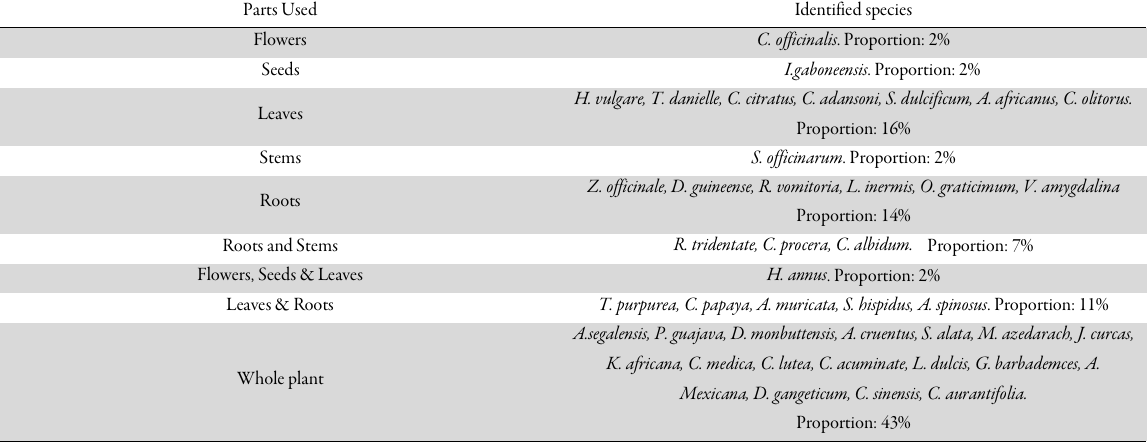
Table 4. Parts used for medicine in the identified plant species in Badagry Local Government, Lagos State